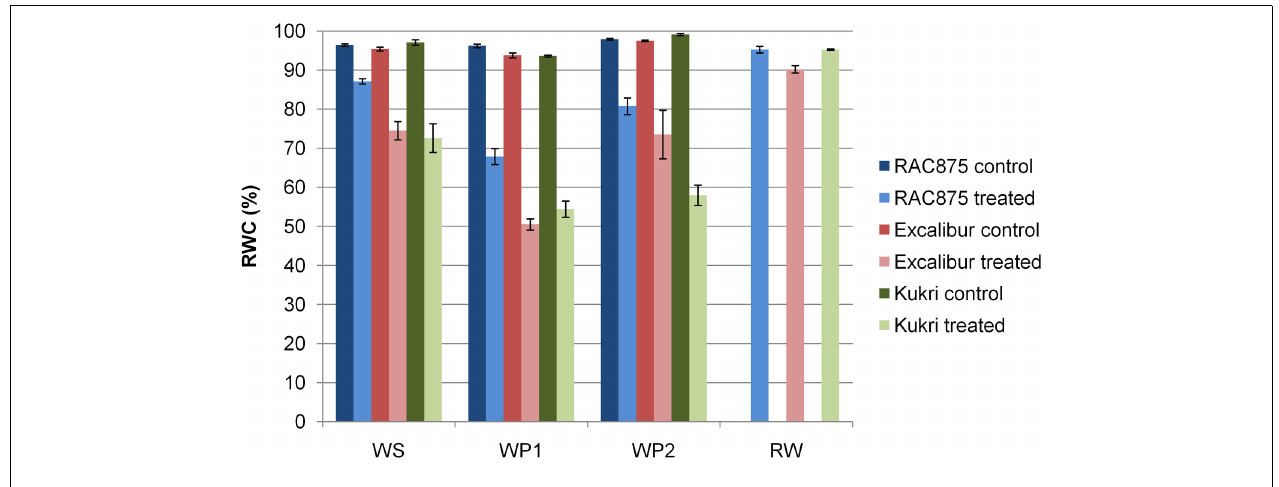
and RW, re-watered at day 25. Control plants were not measured at day 25 but are assumed to mirror results of controls from other sampling time points where values remained constant and greater than 90%.